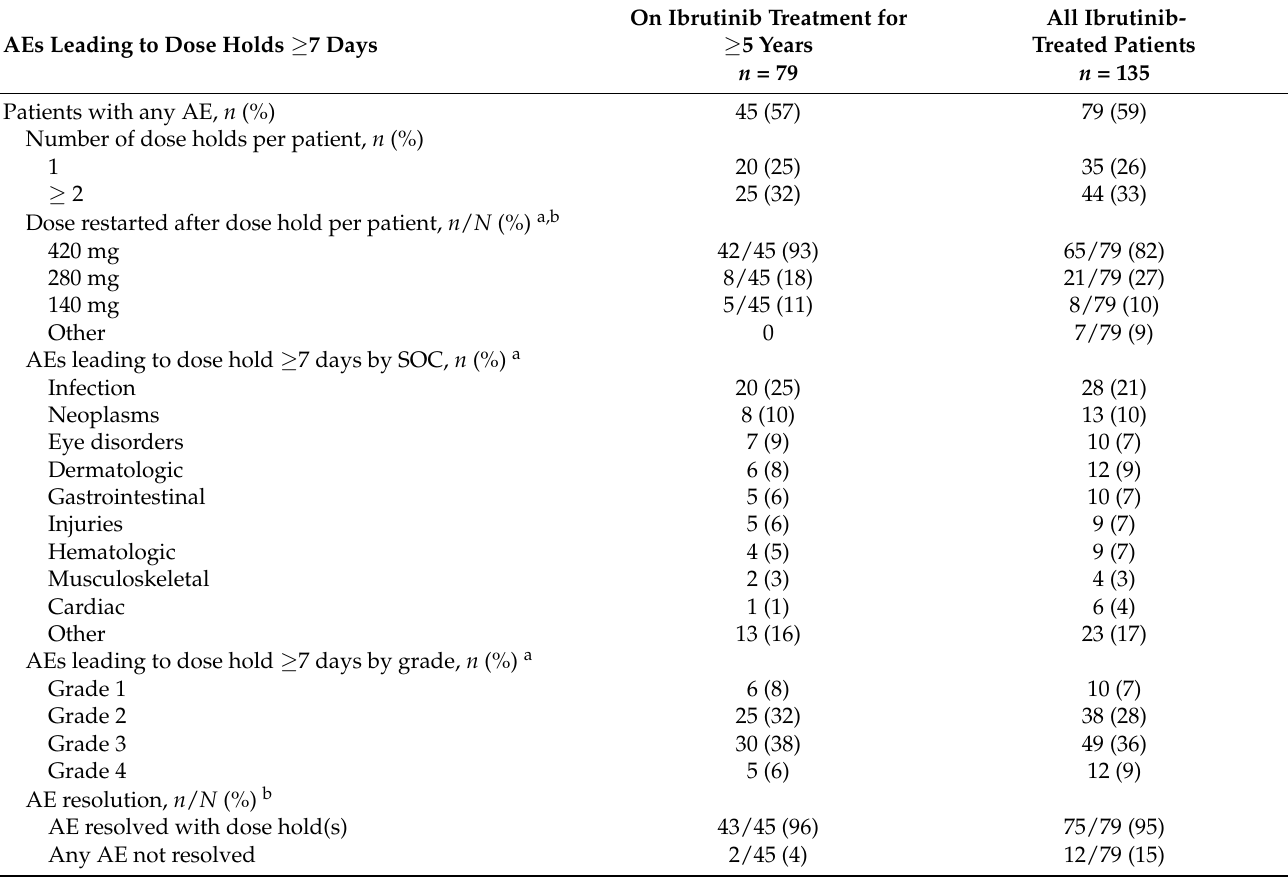
Table 4. AEs leading to dose holds ≥ 7